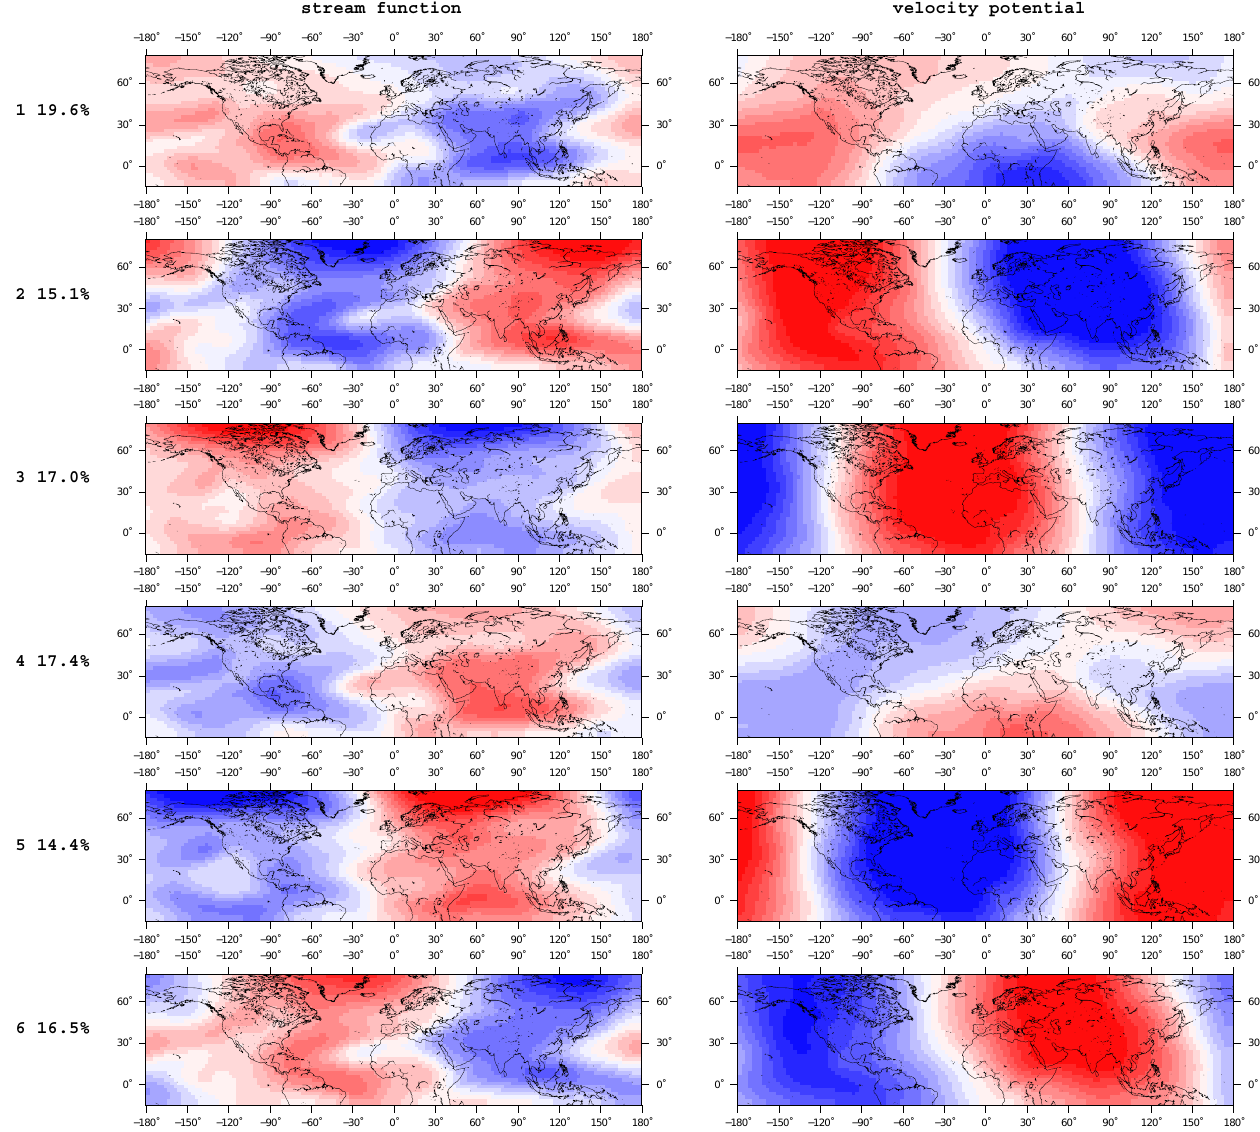
Fig. 3. ERA40 χψ 200 clusters and their corresponding frequency of occurrence; stream function on the left and velocity potential on the right. Contour interval 0.1 (normalised